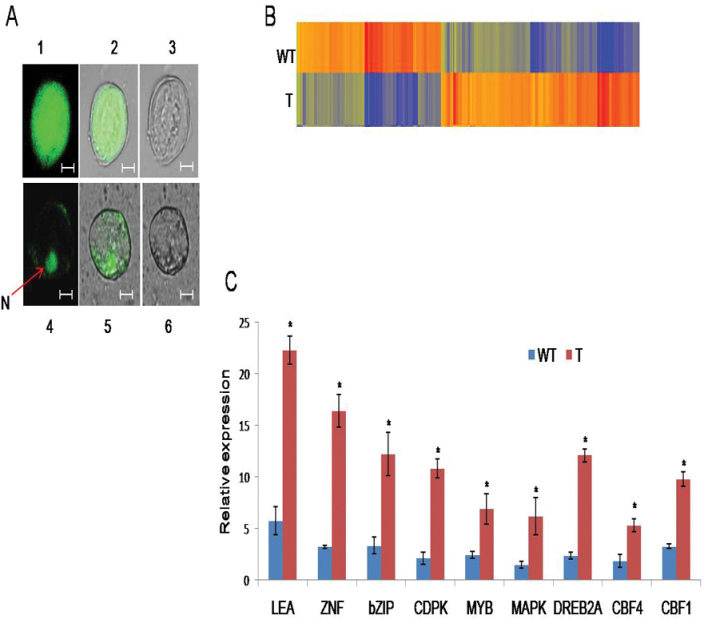
Subcellular localization and expression profile of CcCDR in transgenic Arabidopsis. (A) Subcellular localization of CcCDR. Plasmid constructs harbouring CaMV35S-GFP and CaMV35S-CcCDR::GFP were introduced into Arabidopsis independently by floral infiltration. Individual cells of callus derived from roots of transgenic plants were observed under a confocal microscope. Images 1 and 4 are dark field, 2 and 5 are combined, 3 and 6 are bright field. Ths scale bar=50 μm. N represents the nucleus. (B) Transcriptome profile of wild-type and rd29A-CcCDR-transgenic plants under drought stress by microarray analysis. Two-week-old seedlings were subjected to 200mM mannitol stress for 72h. The heat map represents normalized expression intensity values of differentially regulated genes (fold change ≥2 and P-value <0.05) in the RD2 transgenic line (T) as compared with the wild type (WT). Dark color shows overexpressed genes and light color shows underexpressed genes. (C) Expression profiles of stress-responsive genes under drought stress by qRT-PCR analysis. Comparisons of the relative transcript levels of LEA, ZNF, bZIP, CDPK, MYB, MAPK, DREB2A, CBF4, and CBF1 in rd29A-CcCDR-transgenic (T) and wild-type (WT) plants and under 200mM mannitol stress for 72h. Actin was used as an internal control. The vertical column indicates the relative transcript level. The mean and SE from three independent experiments are shown. * indicates significant differences in comparison with the control at P<0.05. (This figure is available in colour at JXB online.)